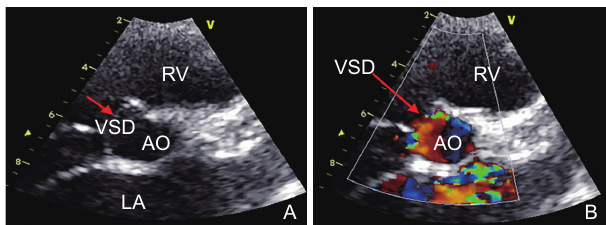
Figure 5 (A) Parasternal short-axis view showing a VSD (largest diameter = 16 mm) with pseudoaneurysm (red arrow) formed by septa tricuspid and chordae tendineaes. (B) Parasternal short-axis view with color Doppler showing no shunt between left and right